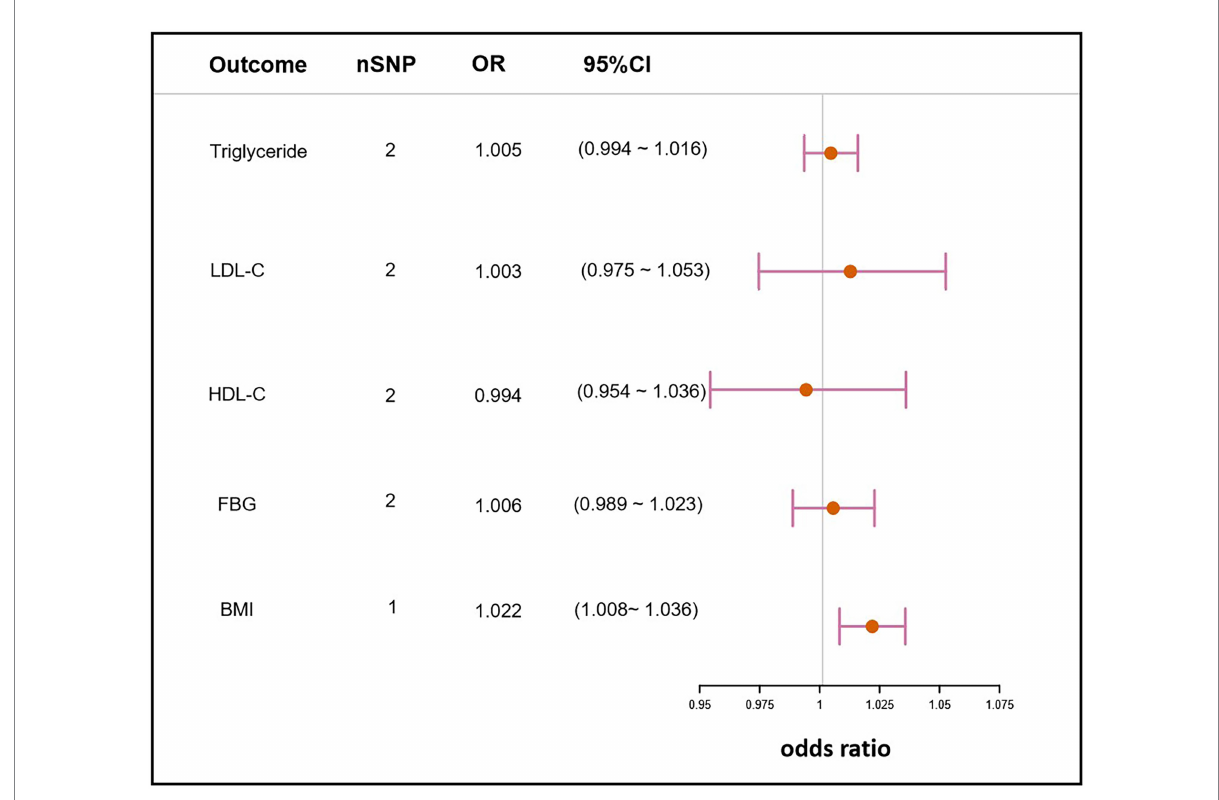
FIGURE 4 Mendelian randomization result of the effect of H. pylori infection on clinical traits related to NAFLD. nSNP, the number of SNPs used in the analysis and the SNP rs10004195 was used if nSNP = 1. The SNPs rs10004195 and rs368433 were used if nSNP = 2. LDL-C, low density lipoprotein cholesterol; HDL-C, high density lipoprotein cholesterol; FBG, fasting blood glucose; BMI, body mass index; OR, the odds ratio. 95% CI, 95% confidence